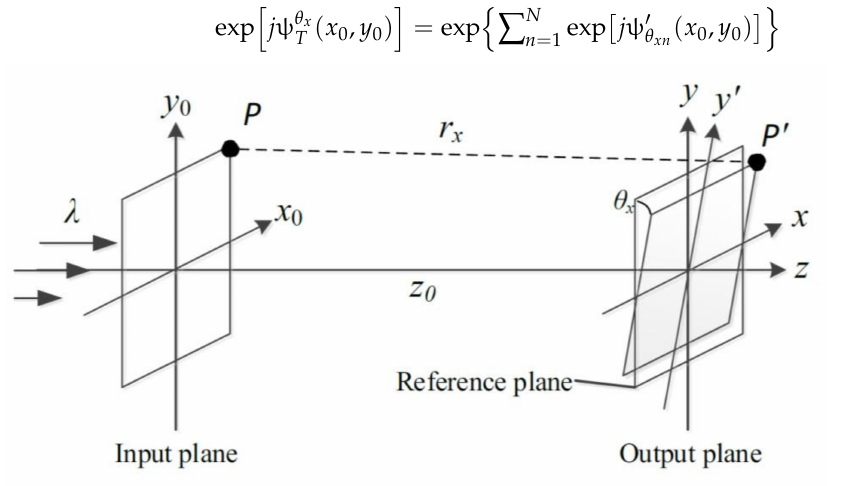
Figure 1. FrT space coordinates relationship diagram of the input plane revolving the x axis.